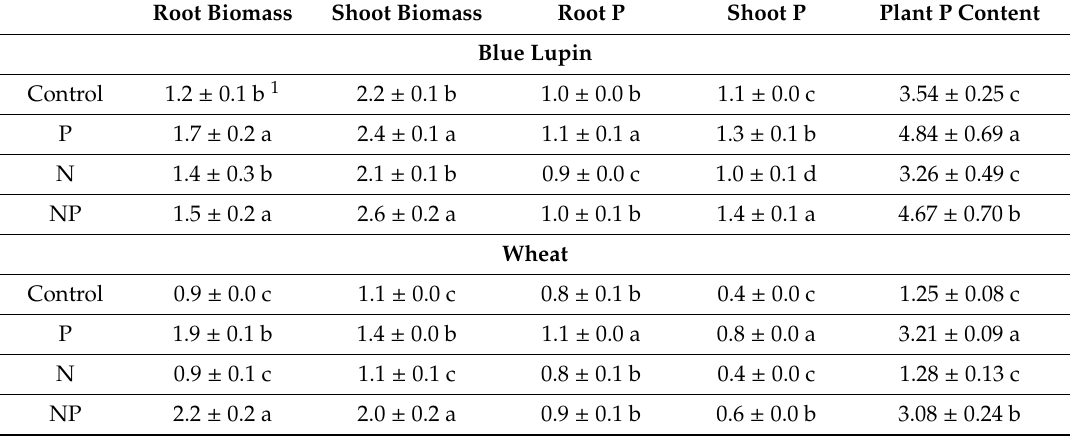
Table 1. Root and shoot biomass (g tube − 1 ), root and shoot P concentration (mg g − 1 ), and total P content (mg tube − 1 ) values for blue lupin, wheat, ryegrass, and white clover under the di ff erent nutrient